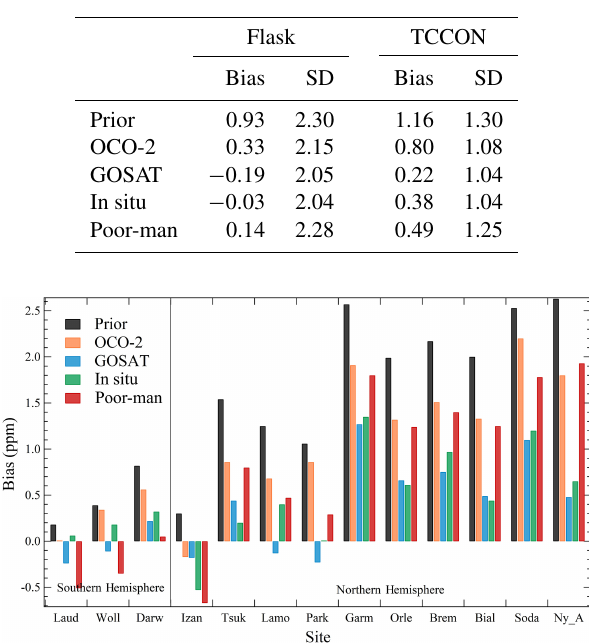
Table 1. Statistics of the model–data mismatch errors at the 52 sur- face flask sites and the 13 TCCON sites (ppm).